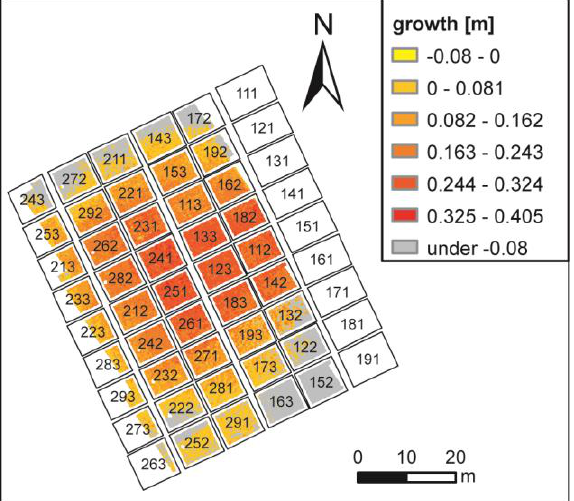
Figure 6. Plant growth of flight strip 2 for GP1 (Esri ArcMap).